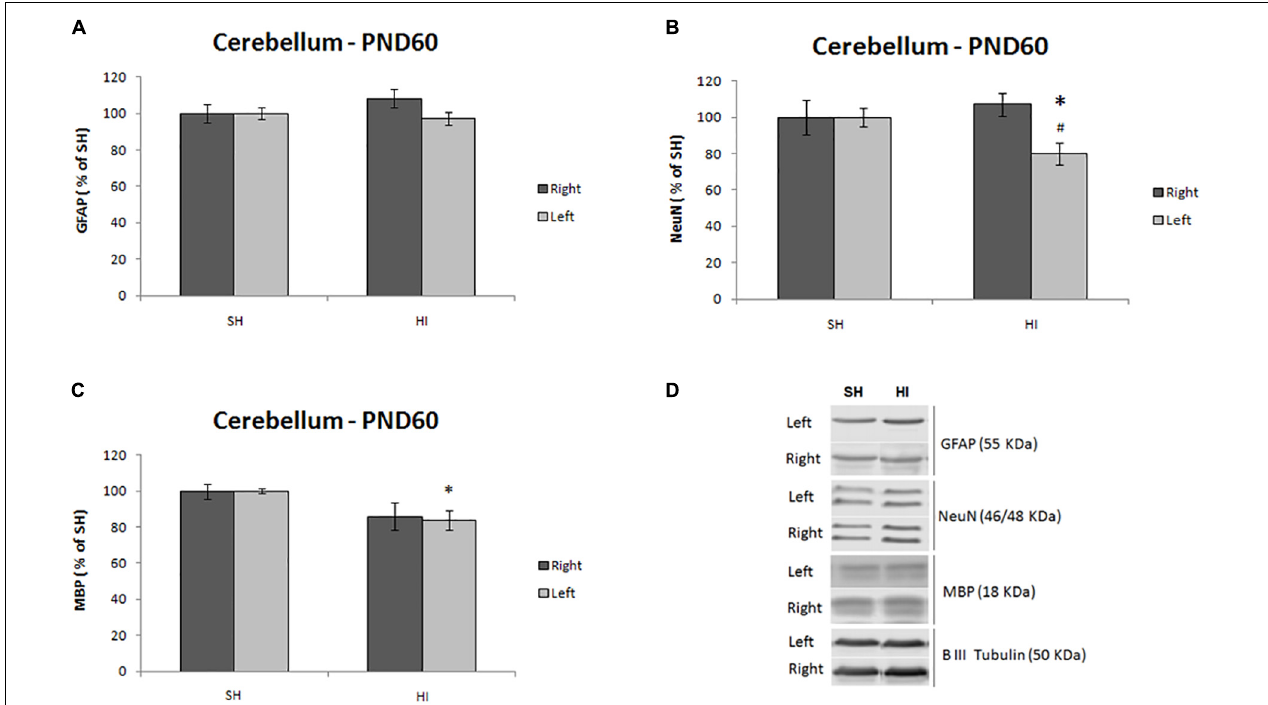
FIGURE 3 | Summary of protein expression of astrocytes (GFAP, A ), neurons (NeuN, B ), and myelin (MBP, C ) in both hemispheres of the cerebellum in adult rats (PND60) after HI or SH at PND3. The representative blots for the NeuN, GFAP, and MBP, for SH and HI groups, were shown in panel (D) . Western blotting results are plotted normalized to SH expression level (100%) (mean ± SEM). “ ∗ ” Stands for difference between HI and SH ( n = 6–8 animals per group), and “ # ” represents difference between right and left hemispheres. Significance was determined using unpaired t -test when p <